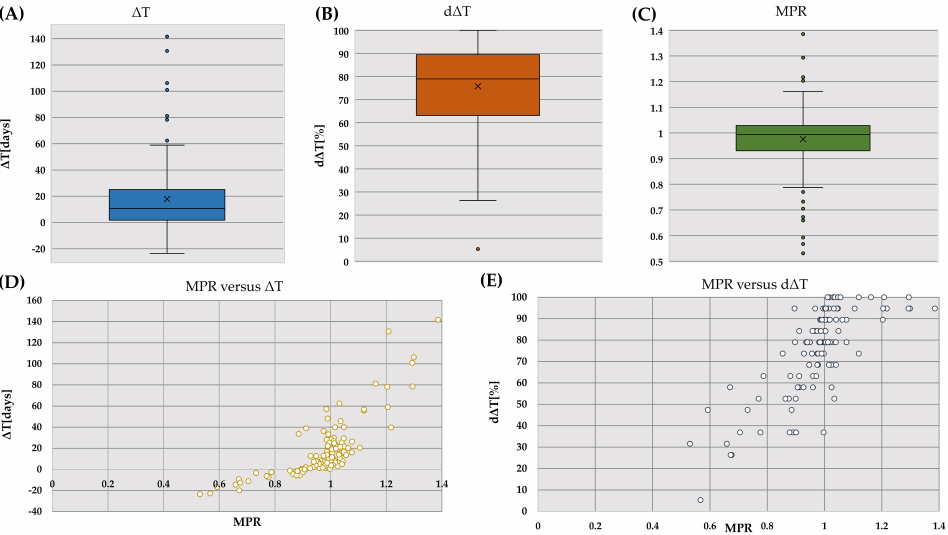
Figure 2. Upper panel: ( A ) distribution of Δ T around the mean of 17.8 ± 27.9; ( B ), distribution of d Δ T around the mean of 75.8 ± 20.2%; ( C ) distribution of MPR around the mean of 0.975 ± 0.129 lower panel: ( D ) Δ T graphed against the corresponding MPR; ( E ) mean d Δ T graphed against the corresponding MPR. MPR, medication possession ratio; Δ T, mean Δ T; d Δ T, mean dichotomized Δ T. Refer to text for details.